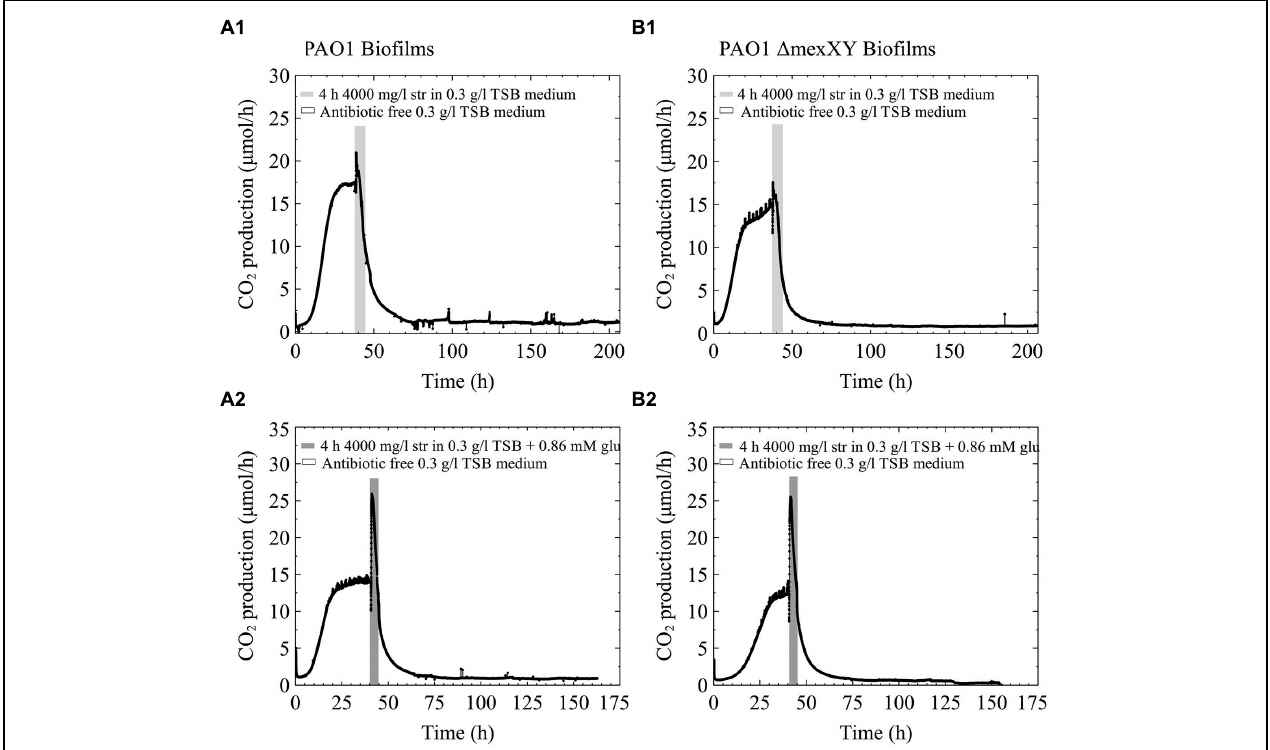
FIGURE 5 | CO 2 production ( µ mol/h) of biofilms of P. aeruginosa PAO1 (A) and PAO1 (cid:2) MexXY (B) grown in 0.3 g/l TSB. The biofilms were grown for less than 48 h and had reached steady state CO 2 output before they were exposed to 4000 mg/l streptomycin for 4 h. (A1) and (B1) biofilms were exposed to streptomycin in 0.3 g/l TSB medium. (A2) and (B2) were exposed to streptomycin in 0.3 g/l TSB medium with the addition of 0.86 mM glucose